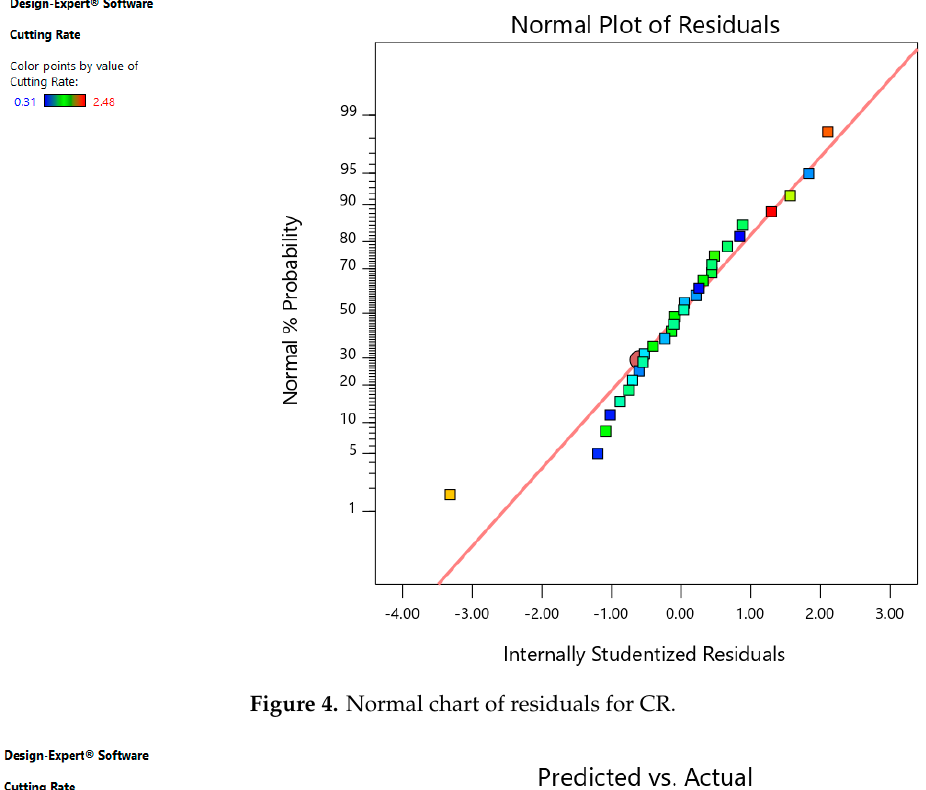
Figure 4. Normal chart of residuals for CR.